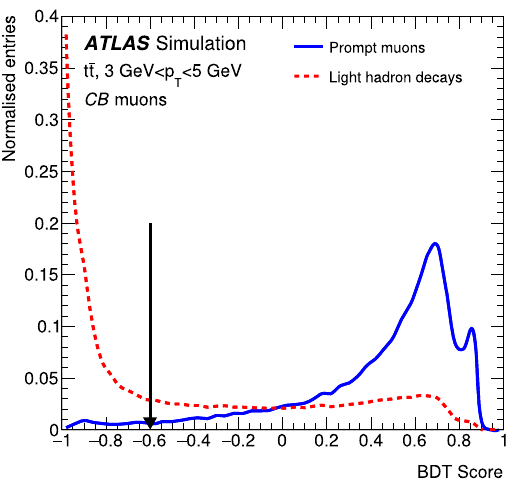
blue), and for light hadron decays (dashed line, red). The black arrows indicate the values of the requirements that define the multivariate Low - p T